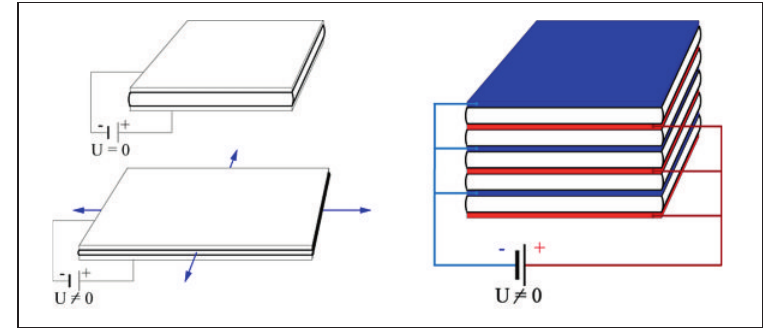
The application of an electrical field leads to shape changes in electrically activated polymer microstructures, since the positive and negative charges attract each other, deforming the incompressible elastomer in-between. For multi-layers, enough strain should be produced even if applying comparably low